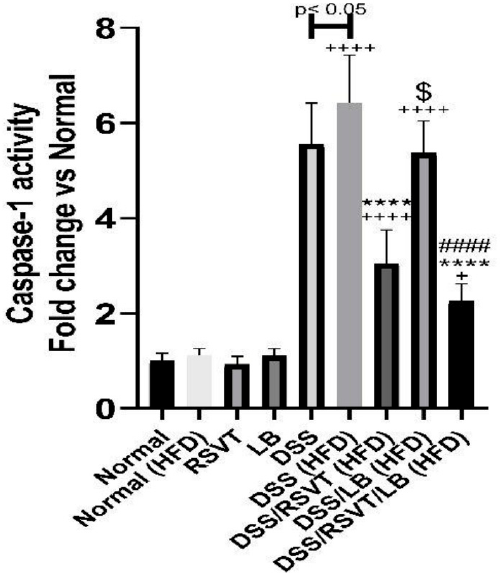
Figure 5. Effect of rosuvastatin (RSVT), Lactobacillus (LB), and their combined therapy on caspase-1. +, p < 0.05 vs. Normal (HFD); ++++, p < 0.0001 vs Normal (HFD); ****, p < 0.0001 vs. DSS (HFD); ####, p < 0.0001 vs. DSS/LB (HFD); $, p < 0.05 DSS/RSVT (HFD) vs. DSS/LB (HFD). DSS (HFD) induced a significant upregulation in the expression of NF- κ B p65, NLRP3, and TXNIP mRNA (Figure 7a–c). The DSS/RSVT (HFD) and DSS/RSVT/LB (HFD) rat groups showed a significant decrease in the expression of NLPR3 compared with that of the DSS (HFD) group. However, the DSS/LB (HFD) group did not significantly affect the level of NLPR3 expression. The DSS/RSVT/LB (HFD) group exhibited a significant decrease in NLPR3 mRNA compared with that of the DSS/LB (HFD) group ( p < 0.05). The DSS/RSVT (HFD) group showed a significant decrease in NLPR3 expression compared with the DSS/LB (HFD) group ( p < 0.05) (Figure 7a). By contrast, compared with the DSS (HFD) group, the DSS/LB (HFD) and DSS/RSVT/LB (HFD) groups showed a significant decrease in NF- κ B p65 mRNA expression levels. How- ever, the DSS/RSVT (HFD) group did not show a significant change in the level of NF- κ B p65 mRNA expression. The DSS/LB (HFD) treatment group exhibited a significant down- regulation in NF- κ B p65 expression compared with the DSS/RSVT (HFD) treatment group ( p < 0.05). The DSS/RSVT/LB (HFD) group showed a significant downregulation in NF- κ B p65 mRNA expression compared with both the DSS/LB (HFD) and DSS/RSVT (HFD) groups ( p < 0.05) (Figure 7b). The DSS/RSVT (HFD) and DSS/RSVT/LB (HFD) groups showed a significant decrease in TXNIP mRNA expression compared with the DSS/HFD group. However, compared with the DSS (HFD) group, the DSS/LB (HFD) group did not show a significant change in the level of TXNIP expression. Finally, the DSS/RSVT/LB (HFD) group showed a significant downregulation of TXNIP mRNA gene compared with both the DSS/RSVT (HFD) and DSS/LB (HFD) groups ( p < 0.05) (Figure